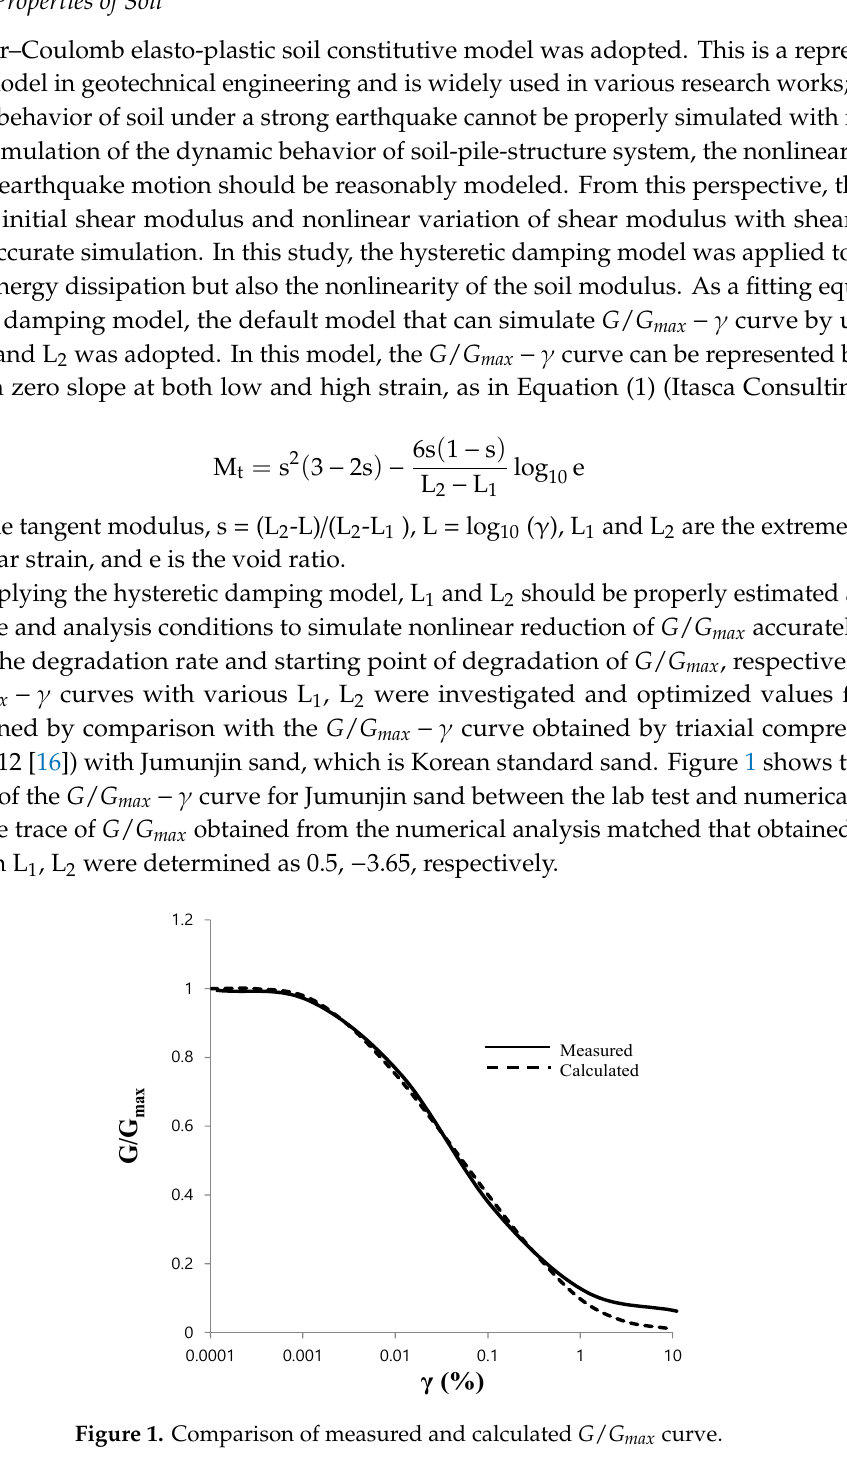
Figure 1. Comparison of measured and calculated 𝐺/𝐺 𝑚𝑎𝑥 curve